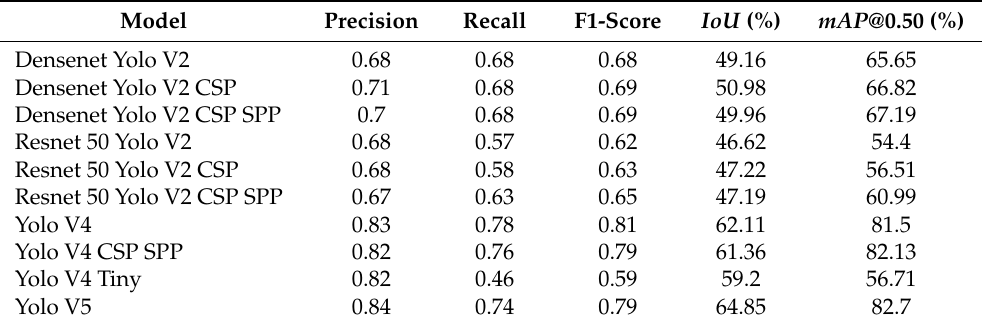
Table 2. Performance of all models during training according to precision, recall, F1-score, IoU , and mAP .